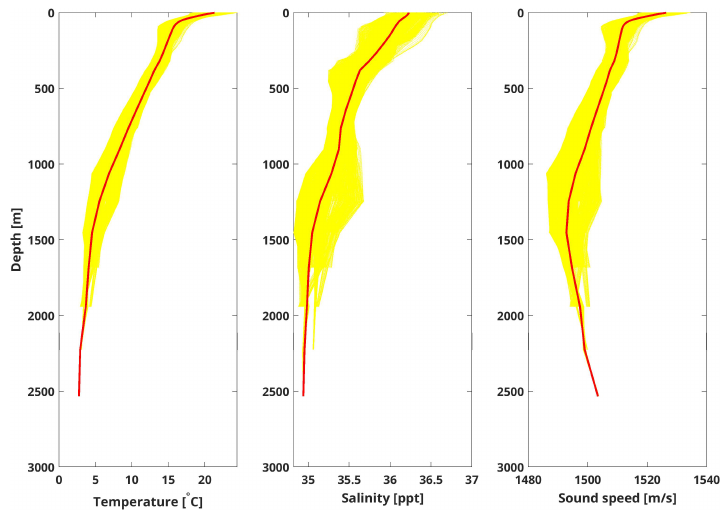
Figure 2. Cumulative temperature, salinity and sound velocity profiles along the study area for the month of June 2018. The mean profiles are shown in red. Source: CMEMS—Copernicus Marine Service. Figure 3 shows the mean wind speed over the month of June 2018 as predicted by the ECMWF 4 [24].